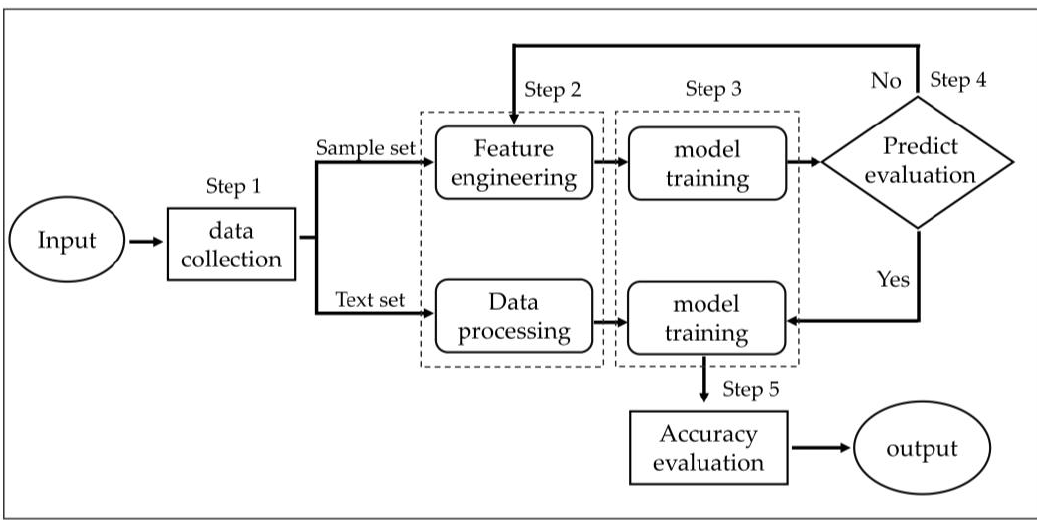
Figure 2. The LightGBM modeling process framework.